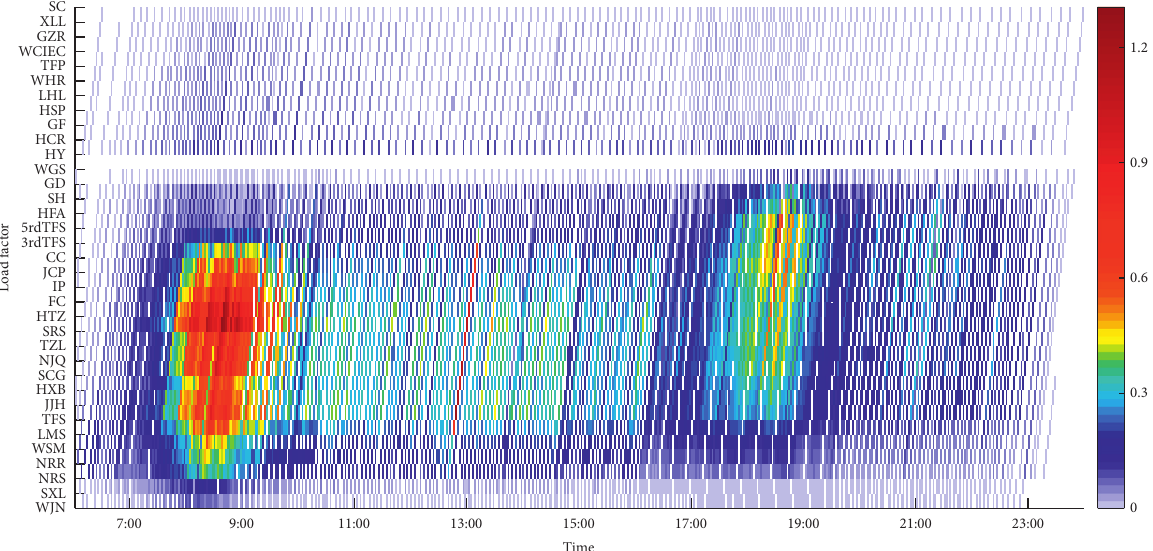
Figure 13: Spatiotemporal load factor for each train on line 1